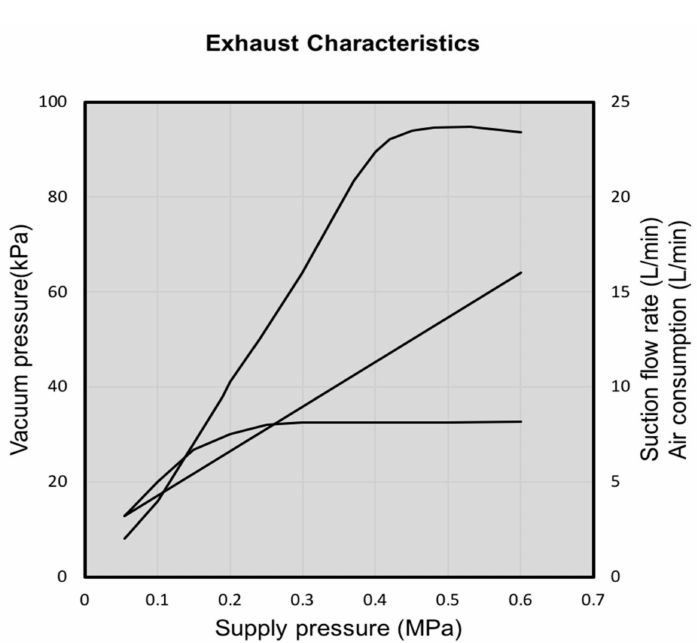
Figure 4. Characteristic curve of the